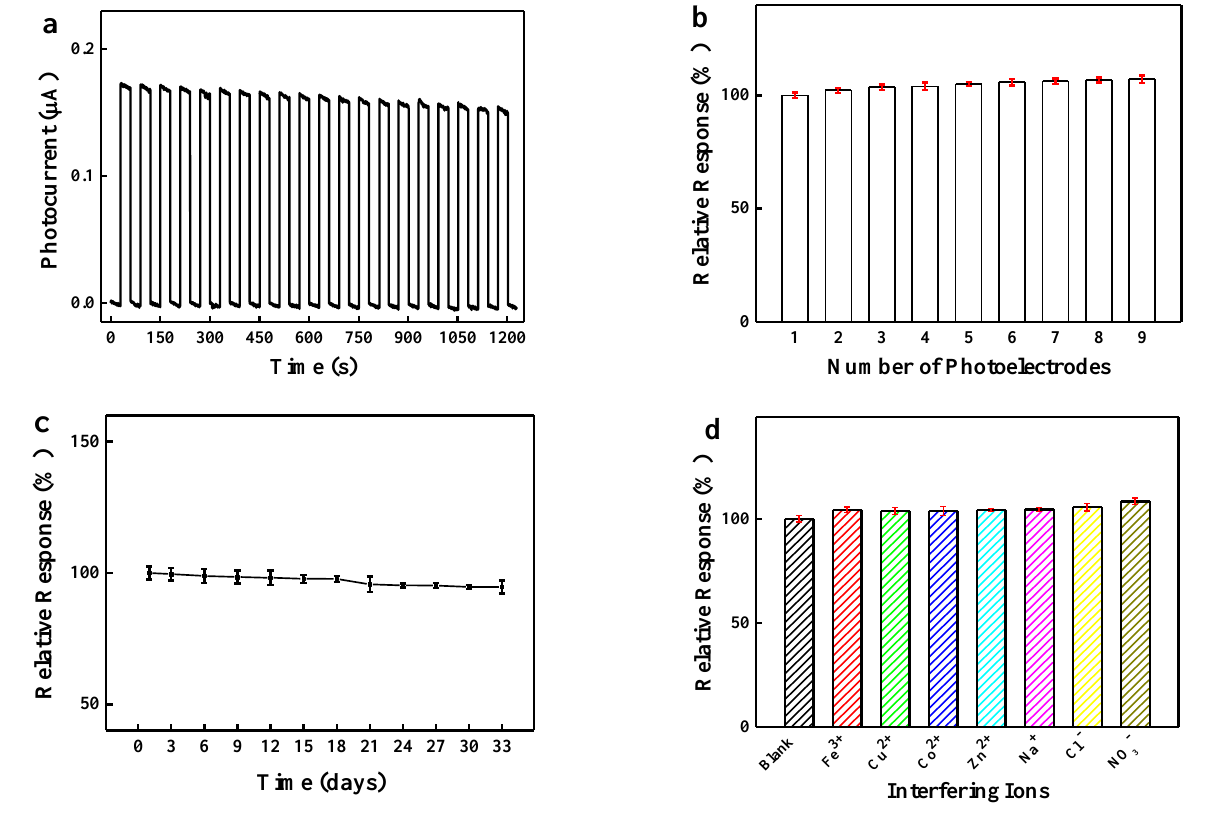
Figure 6. ( a ) The repeatability (short-term stability) for 20 consecutive tests for 50 mM Cr(VI) under a 0.4 V bias voltage; ( b ) reproducibility based on nine parallel photoelectrodes; ( c ) long-term stability, and ( d ) selectivity of the BiVO 4 − 7 sensor.